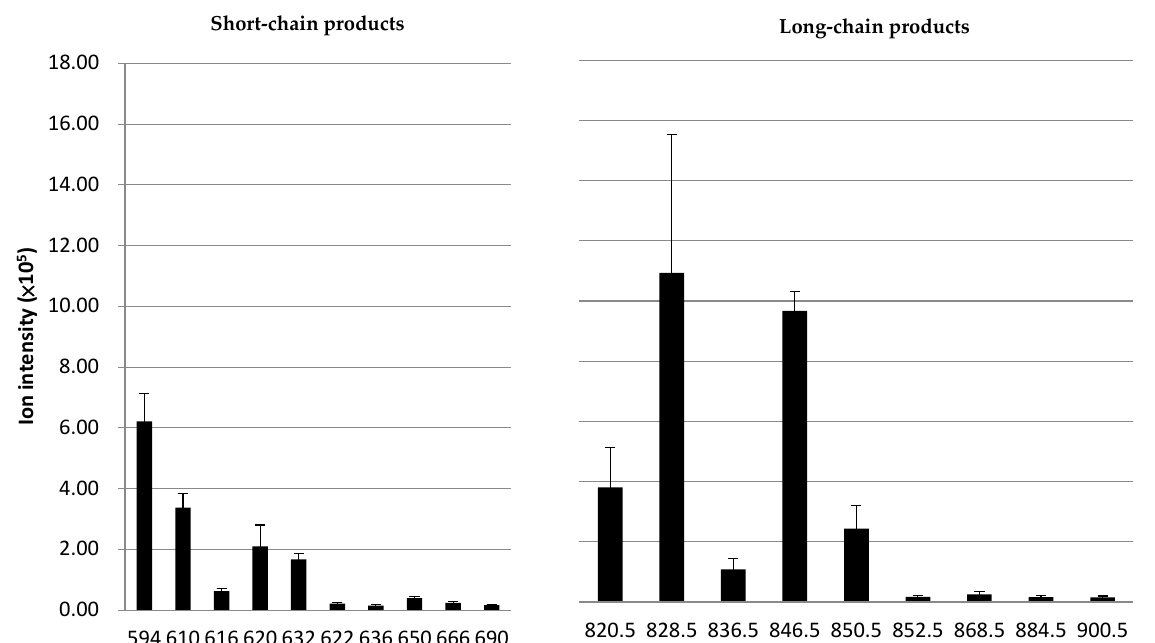
Figure 5. Comparison for the short-chain and long-chain ox-PAPC products. Ox-PAPC was ob- tained by in vitro oxidation (FeCl 2 : H 2 O 2 = 2:1) of 100 µg/mL native PAPC standard at 37 °C for 15 min. The ion intensities of ten short-chain ( m/z 594.0, 610.0, 616.0, 620.0, 622.0, 632.0, 636.0, 650.0, 666.0, and 690.0) and nine long-chain ( m/z 820.5, 828.5, 836.5, 846.5, 850.5, 852.5, 868.5, 884.5, and 900.5) ox-PAPC products were analyzed by ESI-MS. The ESI/MS conditions were as in Figure 4. 3.2. Linear Analysis of the Phospholipid Standard, PC(O-16:0/O-16:0) by LC ESI-MS Using the optimal LC ESI-MS conditions, a phospholipid standard, 1,2-Di-O-hexa- decyl-sn-glycero-3-phosphocholine (PC(O-16:0/O-16:0)), was chosen to determine the lin- ear range of the optimized method. Seven different concentrations of the phospholipid standard (5, 10, 20, 40, 60, 80, and 100 µg/mL ) were measured to determine the linear range. The linear range was 5.0–00.0 µg/mL, and the coefficient of determination (R 2 ) was 0.989. The concentration limit of detection (LOD) of the phospholipid standard was 1.50 µg/mL.